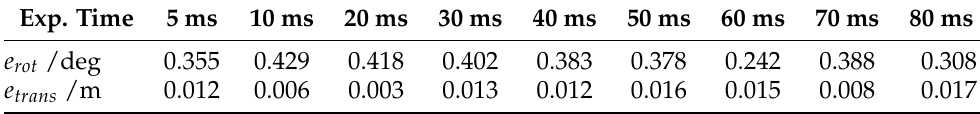
Table 5. Calibration Errors of Extrinsic Spatial Parameters under Different Exposure Times 1